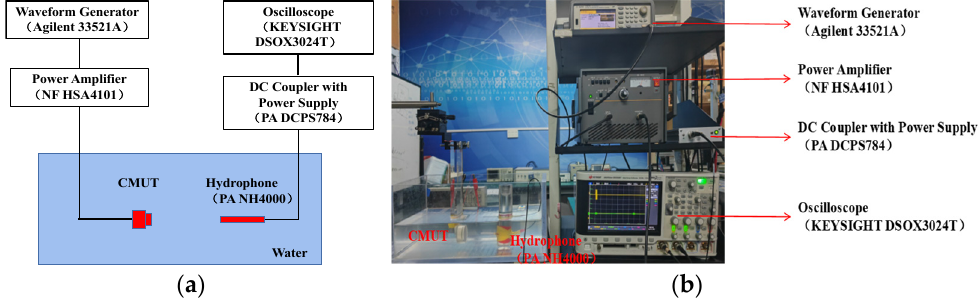
Figure 11. ( a ) Schematic of measurement setup of the CMUT transmitting performance. ( b ) Photo- graph of the measurement setup.